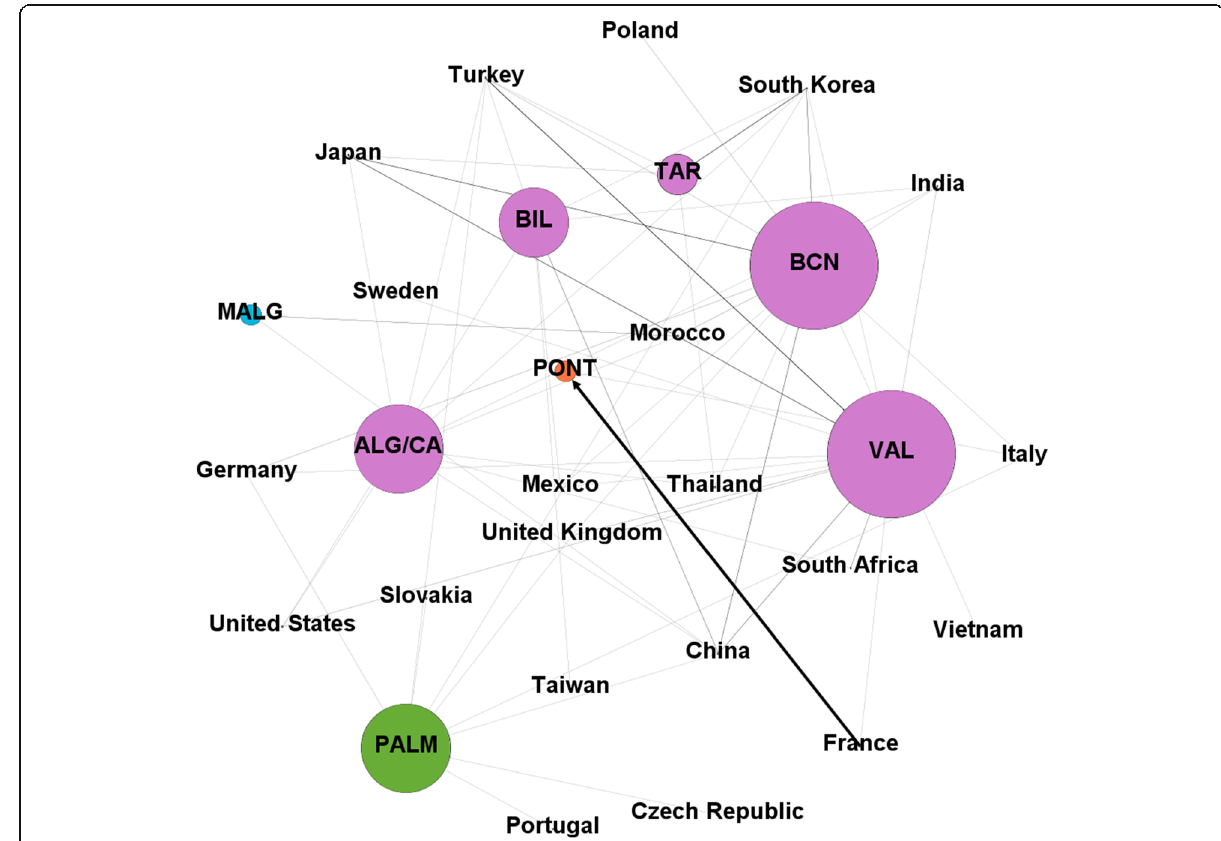
Fig. 4 Main import links for “ Automobiles and their parts ” in 2019. Nodes and arrows are proportional to the degree of the node and the weight of the link respectively. Nodes in the same community are represented with the same color